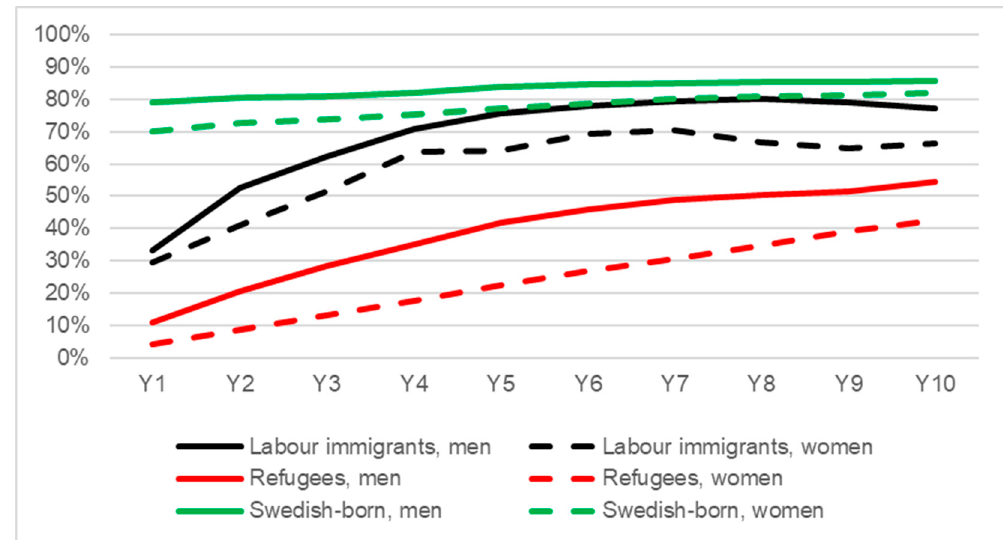
Figure 1. The proportion of labour immigrants, refugees and Swedish-born who have earned over 1.75 PBA 1 from paid work (self-sufficiency) 1–10 years after receiving a residence permit 2 (stratified by sex, n = 169,863). 1 Price base amount, an annual figure, e.g., benefits taking into account inflation; 2 Year of residence permit = year 0. Swedish-born were given a fictive “year 0” 2000–2006 and were matched by age and sex; approx. 5 Swedish-born to each immigrant.